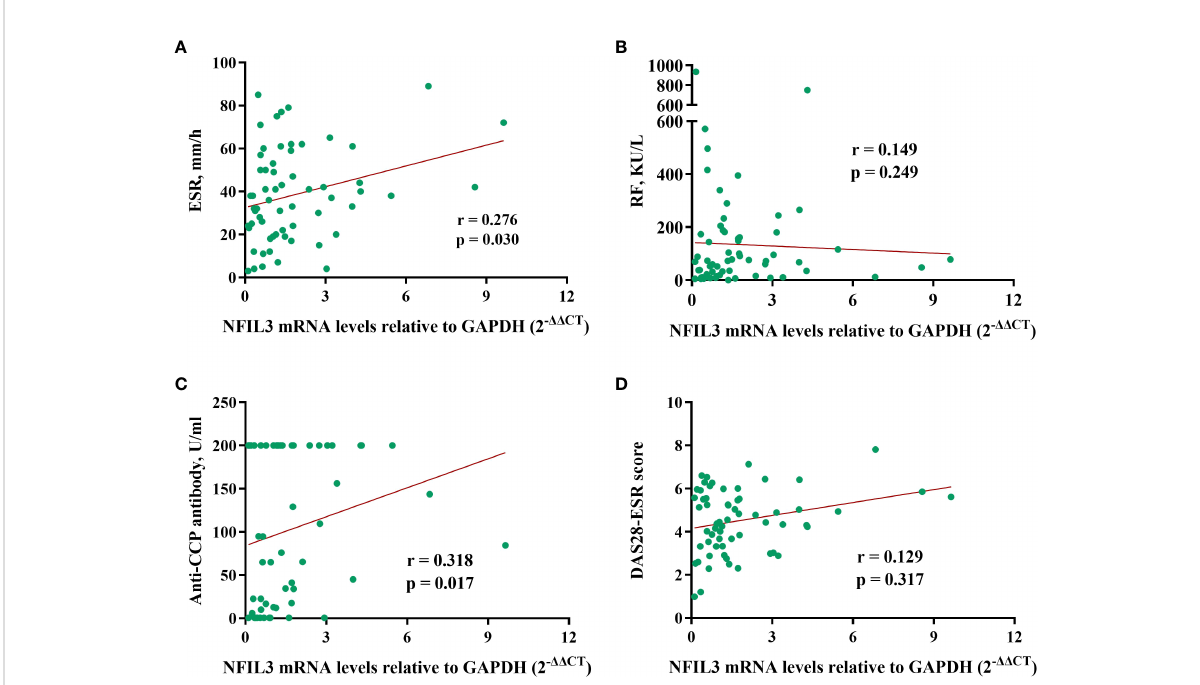
FIGURE 3 Correlations between NFIL3 expression and clinical indexes. (A) ESR, (B) RF, (C) anti-CCP, and (D) DAS28-ESR. ESR, erythrocyte sedimentation rate; RF, rheumatoid factor; anti-CCP, anti-cyclic citrullinated peptide; DAS28-ESR, disease activity score with 28 joints using erythrocyte sedimentation